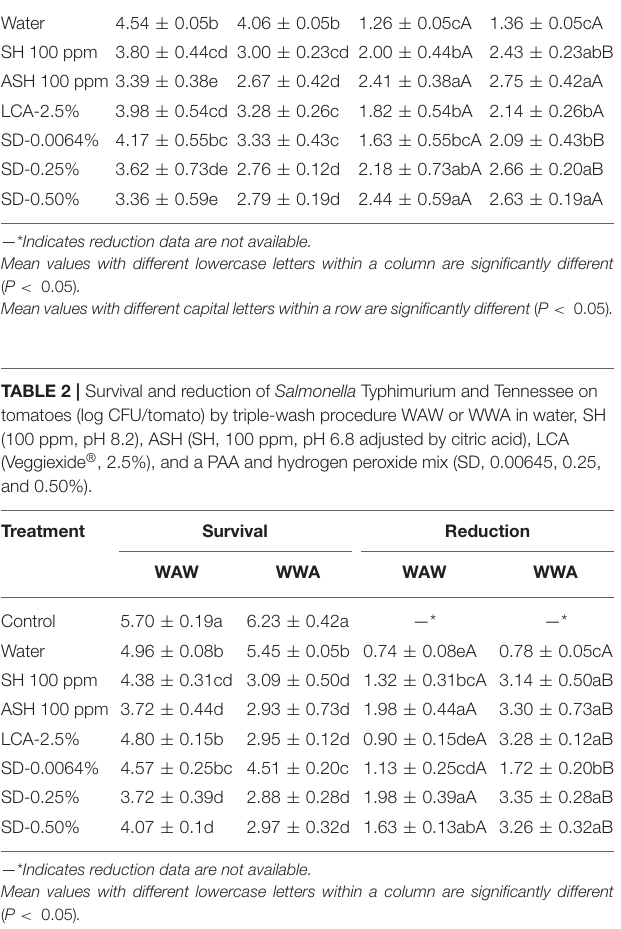
— * Indicates reduction data are not available. Mean values with different lowercase letters within a column are significantly different ( P < 0.05) . Mean values with different capital letters within a row are significantly different ( P < 0.05) .